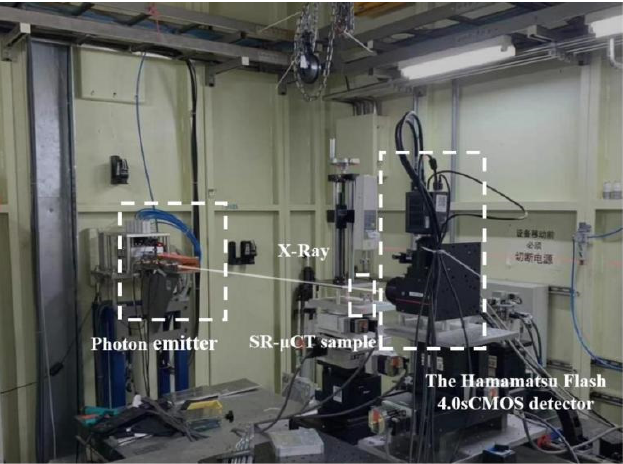
Figure 2. Image of the experimental device for detecting internal defects in the alloy at BL13W1.